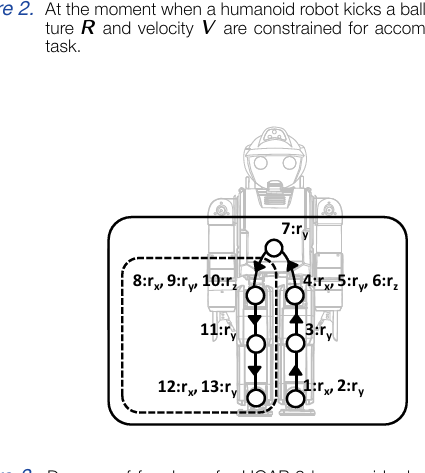
Figure 3. Degrees of freedom of a HOAP-3 humanoid robot (solid line: con- trolled joints in the base motion; dotted line: planned joints from the base motion; r x , r y and r z denote rotatable axes in x , y and z direc- tions, respectively).